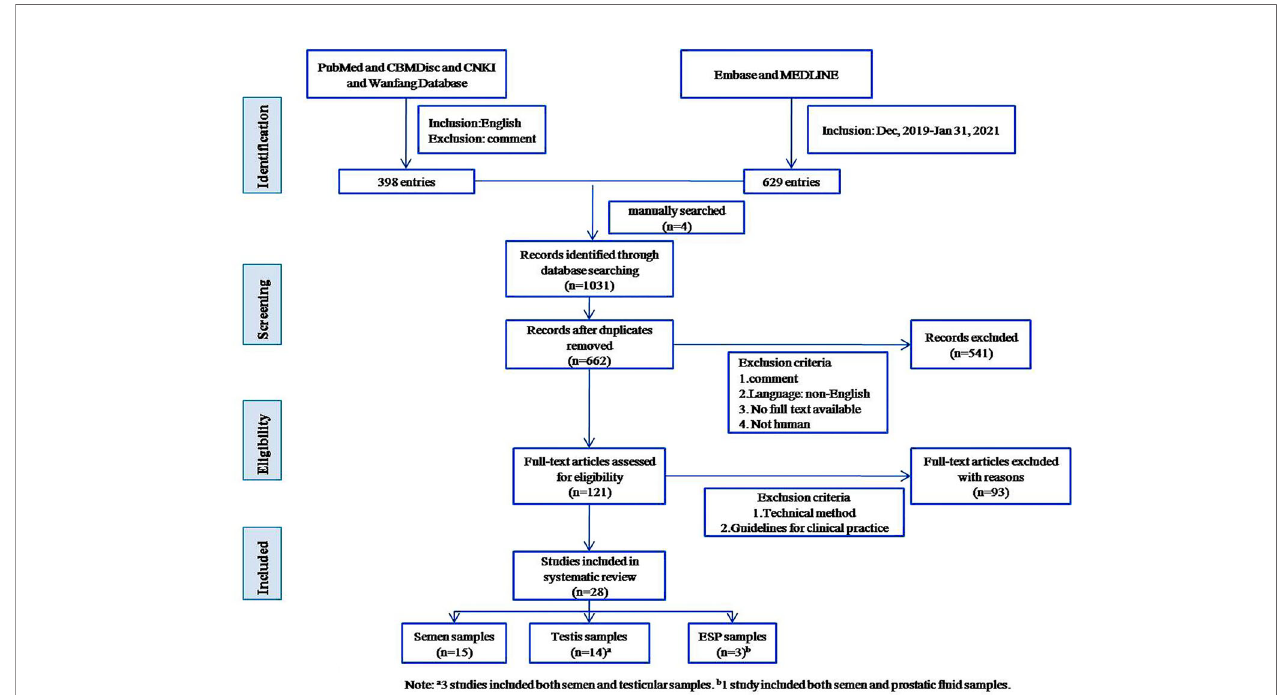
FIGURE 1 | Flow diagram of literature